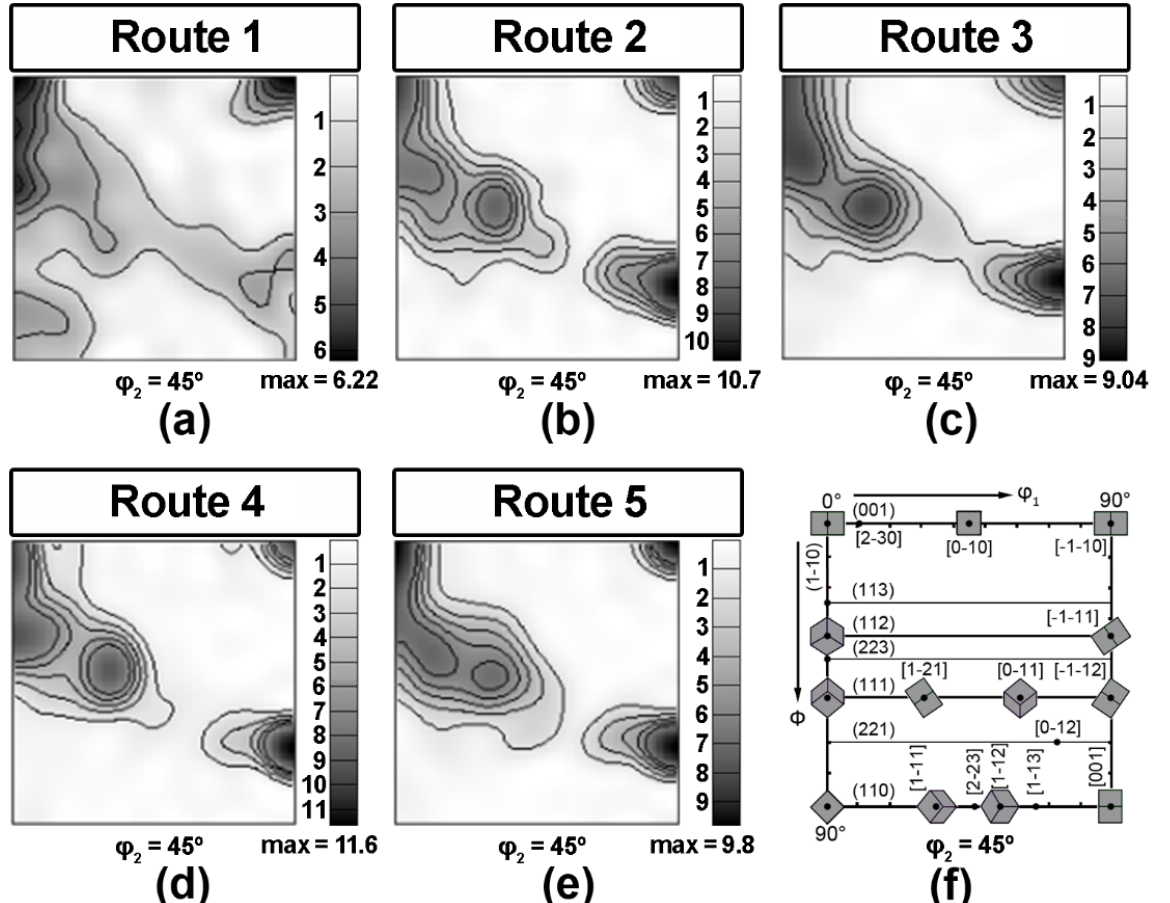
Figure 5. ODF cross-sections for φ 2 = 45° from central area of pipeline steel plates after different TMCP routes ( a – e ), ( f ) standard φ 2 = 45° ODF cross-section. Table 2. Averaged Taylor factors of the central areas of the pipeline steel plates after TMCP. Route X (RD) Y